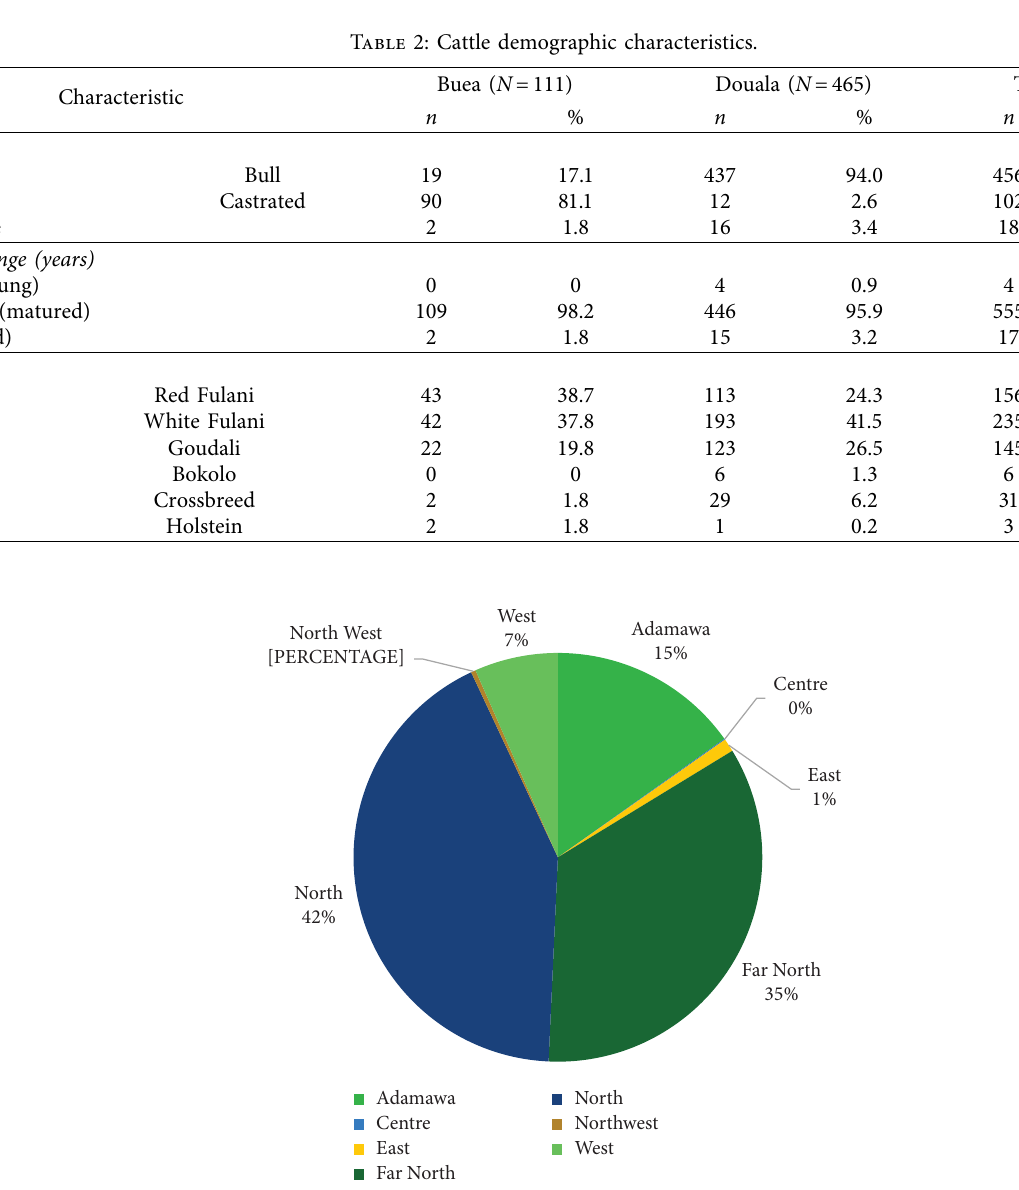
Figure 2: number of cattle that arrived at the cattle market in Douala from diferent regions of the country in the year